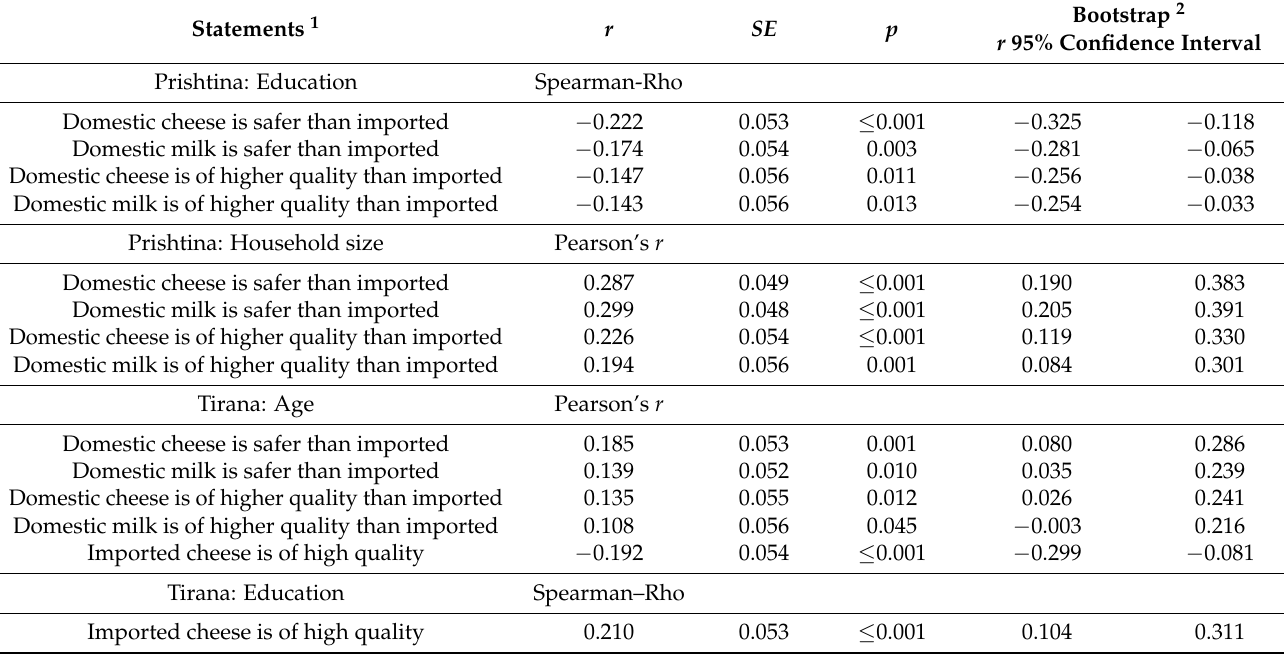
Table 5. Correlation between socio-demographic variables and perception of domestic in comparison to imported dairy food for Kosovo and Albania; correlation coefficients including bootstrap